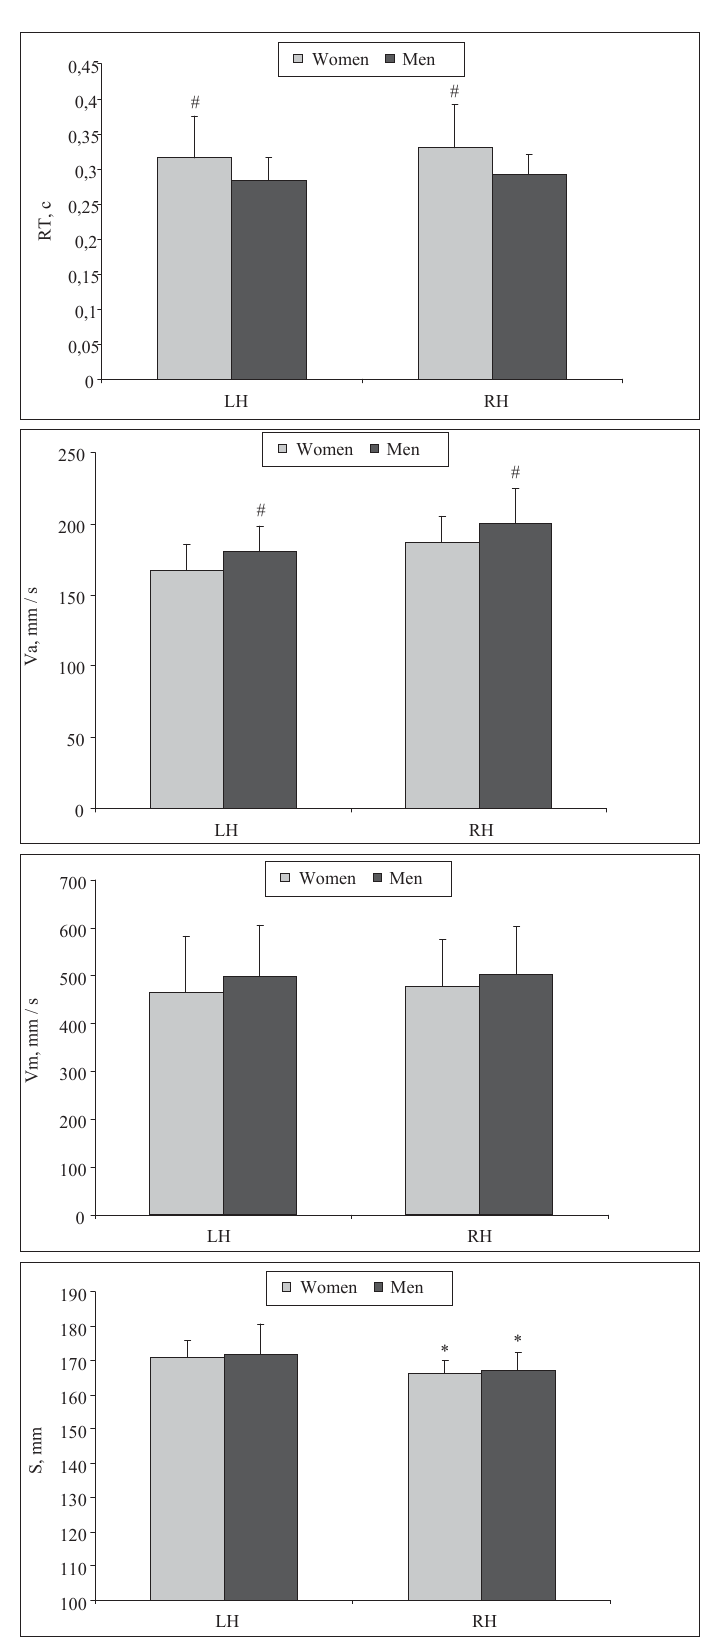
Figure 2. The mean values of the reaction time (s) of males and females performing a task with 50 repeti- tions